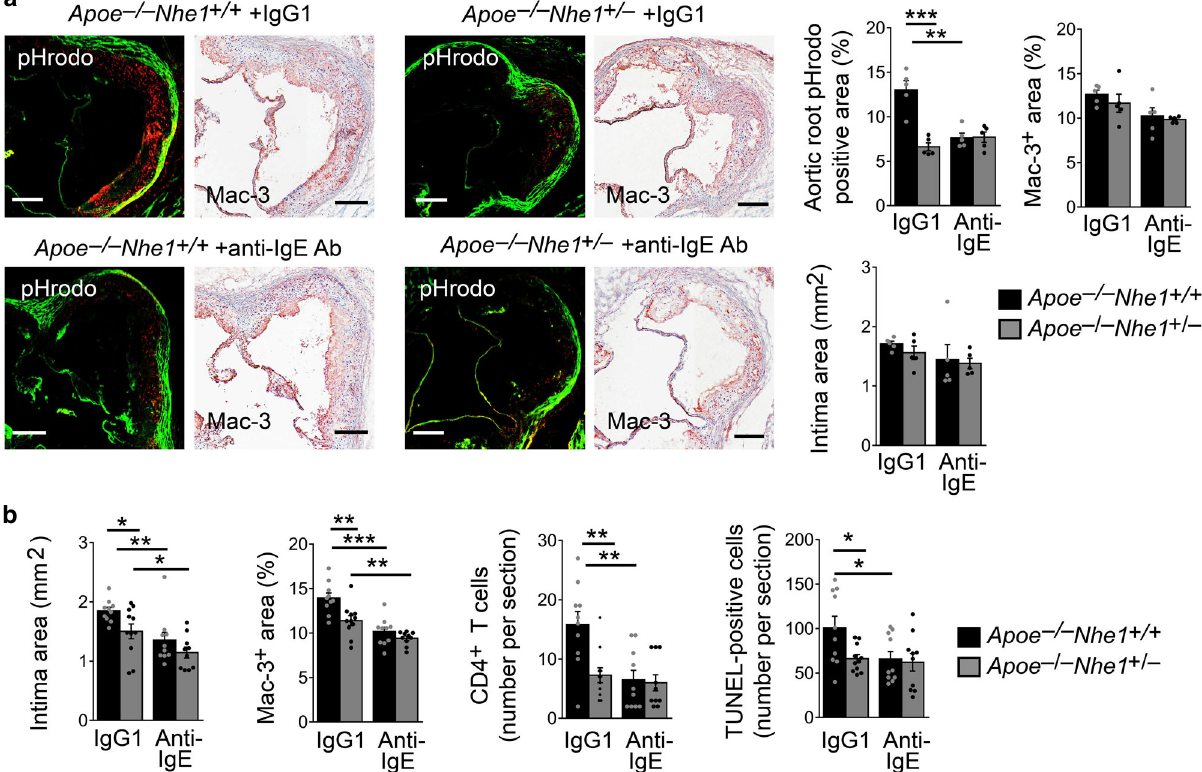
Fig. 6 Anti-IgE antibody blocks atherogenesis and lesion acidi fi cation. a Atherosclerotic lesion pHrodo-positive area, intima area, and Mac-3-positive area from Apoe – / – Nhe1 + / + and Apoe – / – Nhe1 + / – mice treated with IgE antibody ( n = 5 per group) or isotype control IgG1 ( n = 5 per group) as indicated. Lesions are selected with comparable intima size and lesion macrophage contents between the groups. Bars: 200 µ m. b Atherosclerotic lesion intima area, Mac-3- positive area, CD4 + T-cell number, and TUNEL-positive area from both Apoe – / – Nhe1 + / + and Apoe – / – Nhe1 + / – mice treated with IgE antibody ( n = 10 per group) or isotype control IgG1 ( n = 10 – 11 per group) as indicated. Data are mean ± SEM. One-way ANOVA test followed by a post hoc Tukey ’ s test (aortic root pHrodo positive area and Mac-3 + area in a and Mac-3 + area in b ) and Kruskal – Wallis test followed by Dunn's procedure (all other panels) were used to compare three or more groups. * P < 0.05; ** P < 0.01; *** P < 0.001. Source data are provided as a Source Data fi